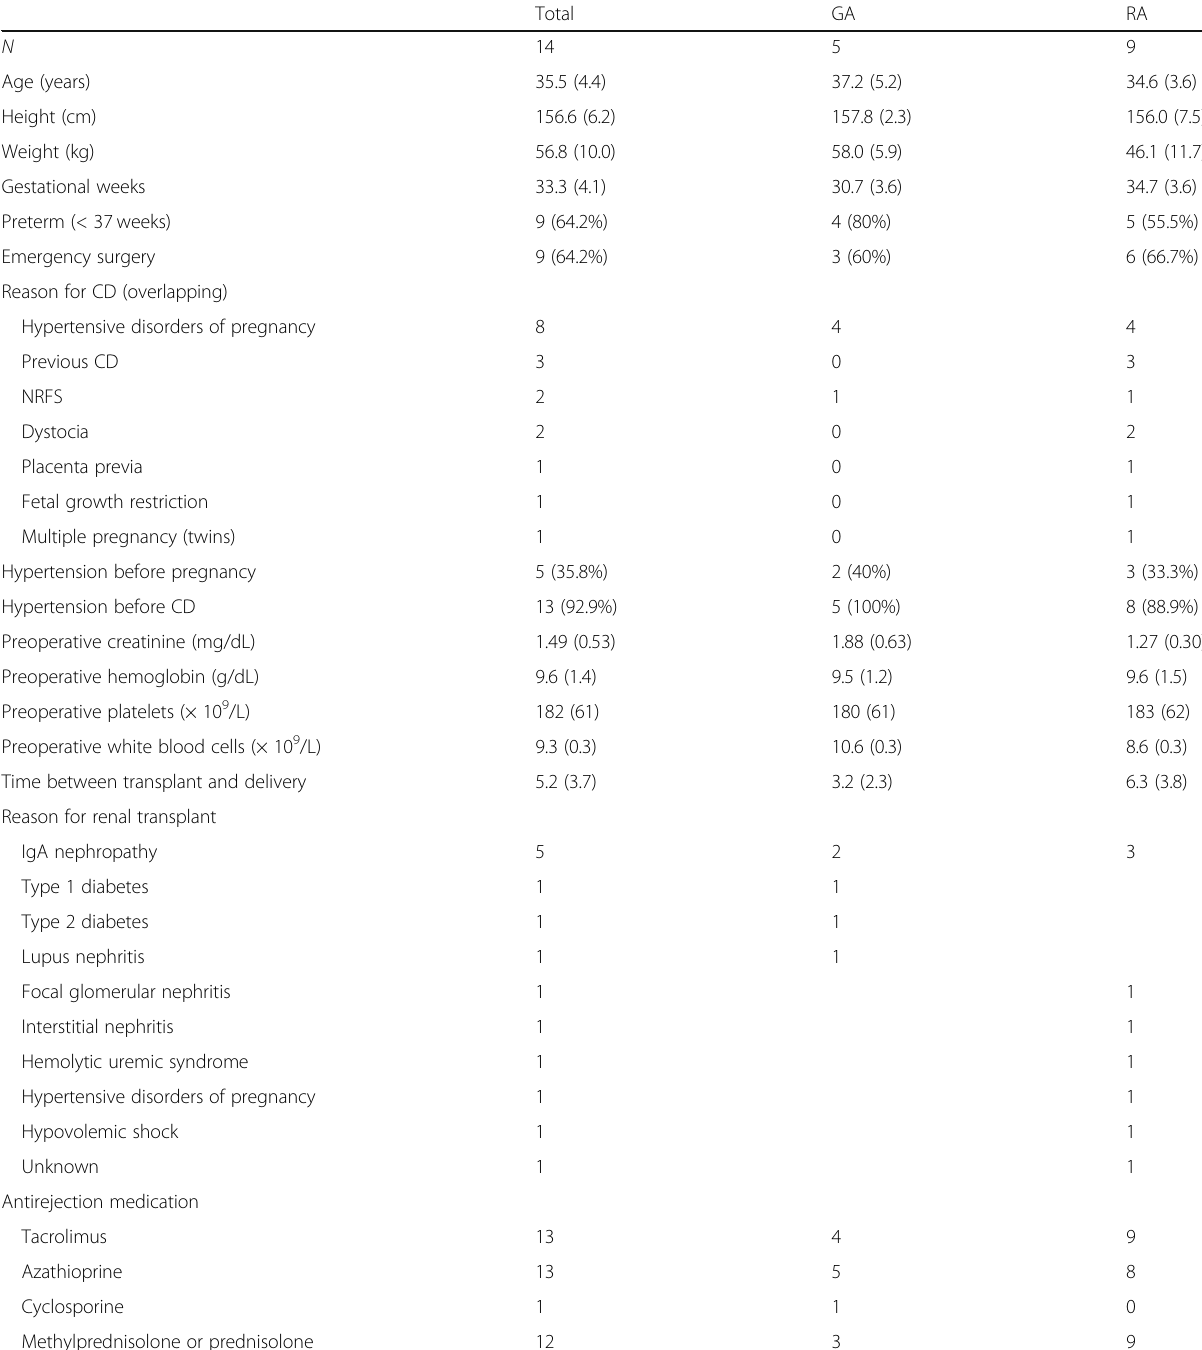
Table 1 Patient